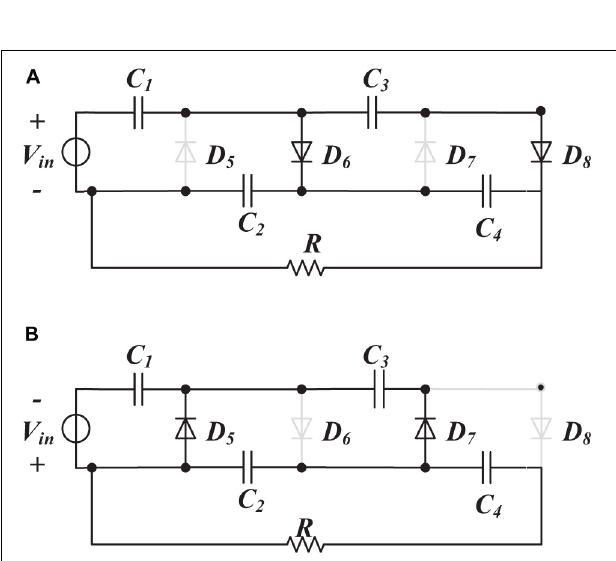
FIGURE 3 | Half-wave four-times voltage rectifier.